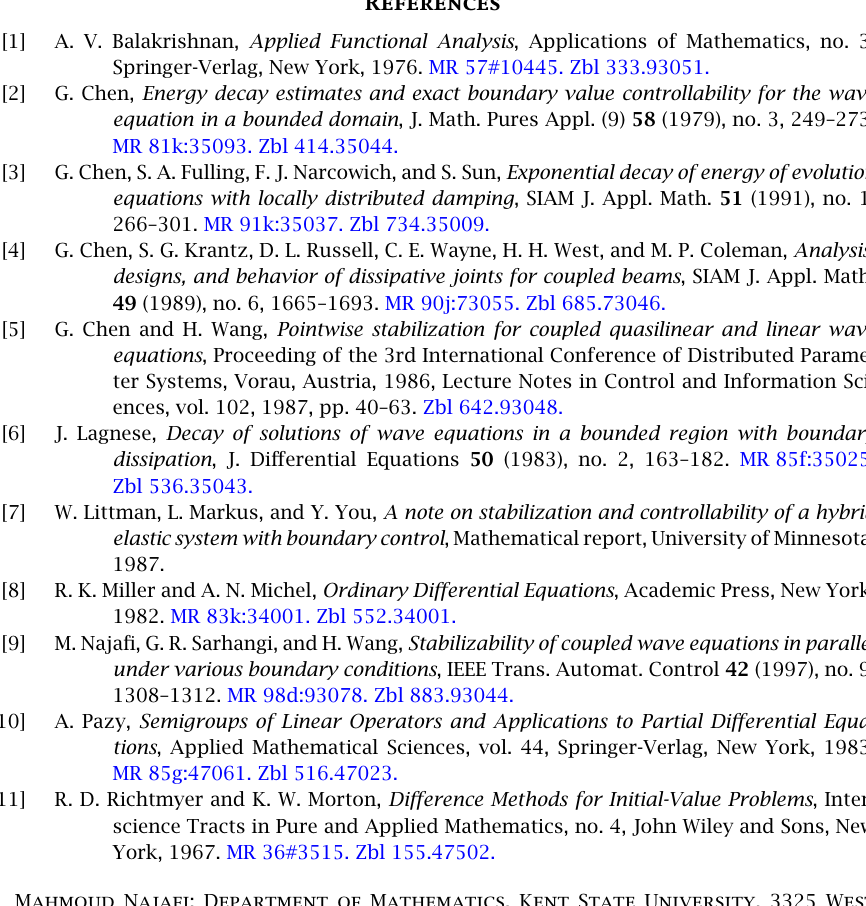
(S5) Check the signs of the first column of Routh’s tabulation which contains infor- mation on the roots of the equation. The roots of the equation are all in the half of the complex-plane if all the elements of this column are of the same